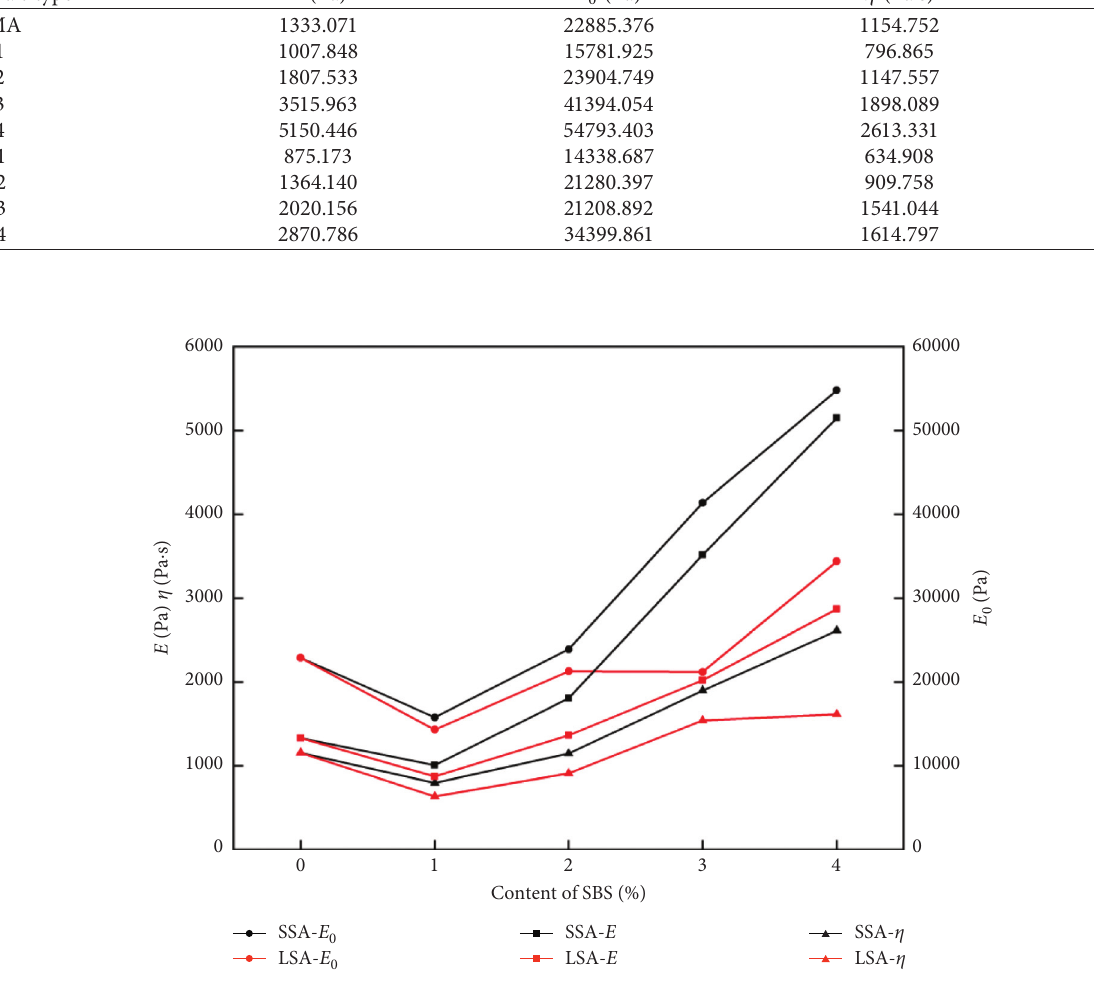
Figure 15: Variation of E , E